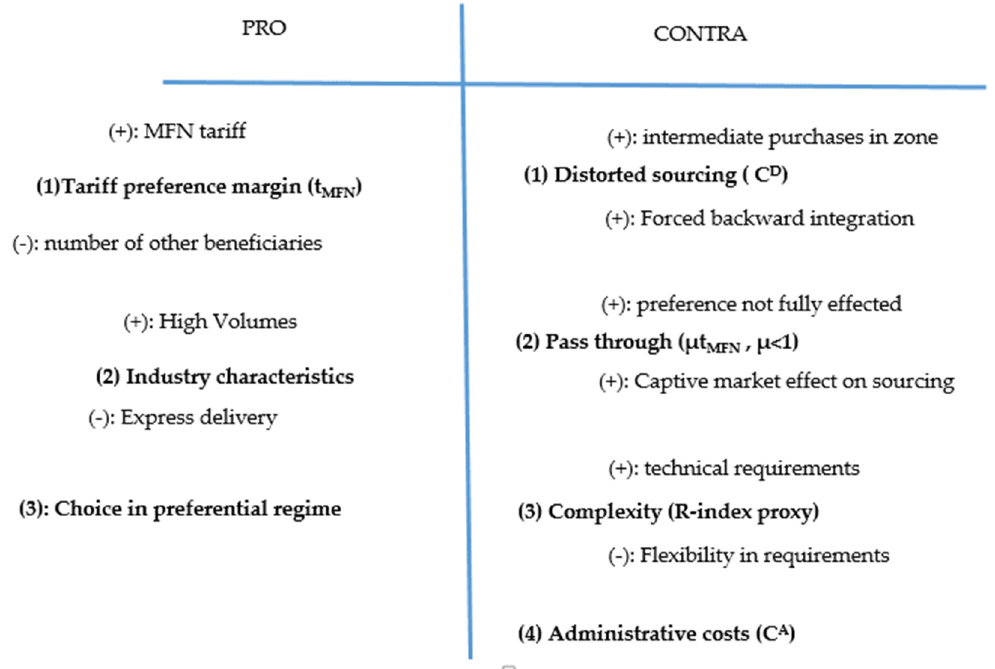
Figure 2. Decision balance sheet for exporter with preferential access option. Source: Authors’ elaboration.